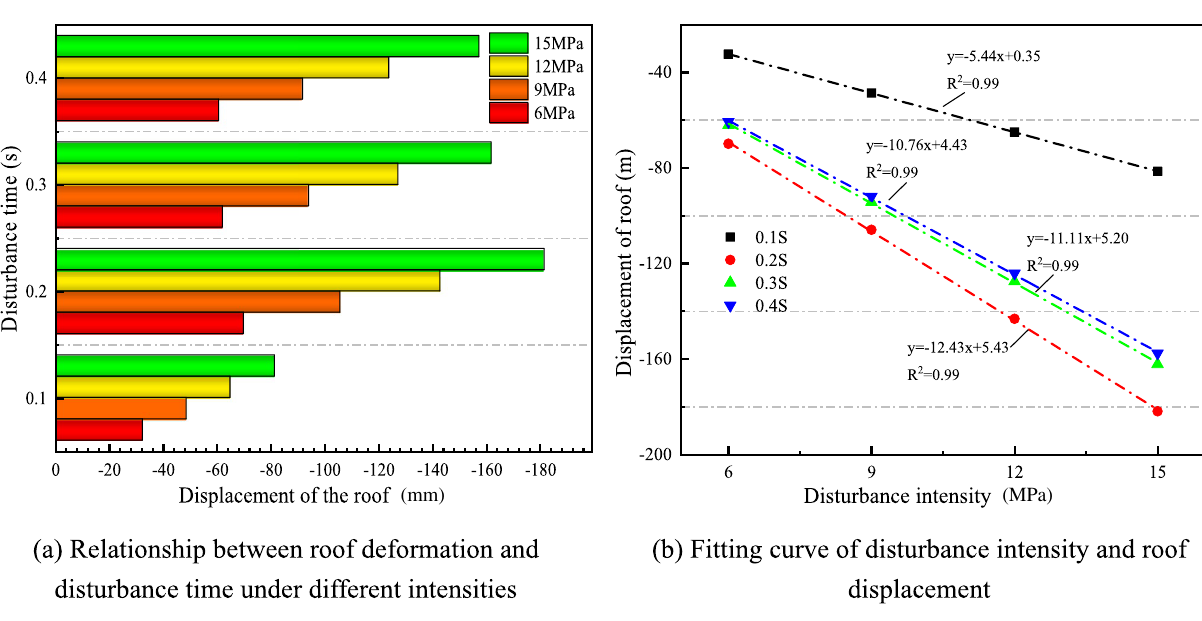
Figure 4. Variation law of roof displacement under different disturbance intensities.